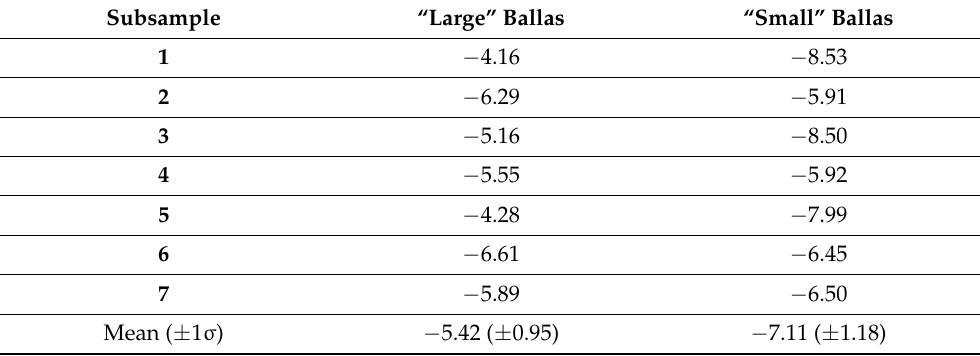
Table 1. Carbon isotopic compositions of the studied ballases ( δ 13 C VPDB,